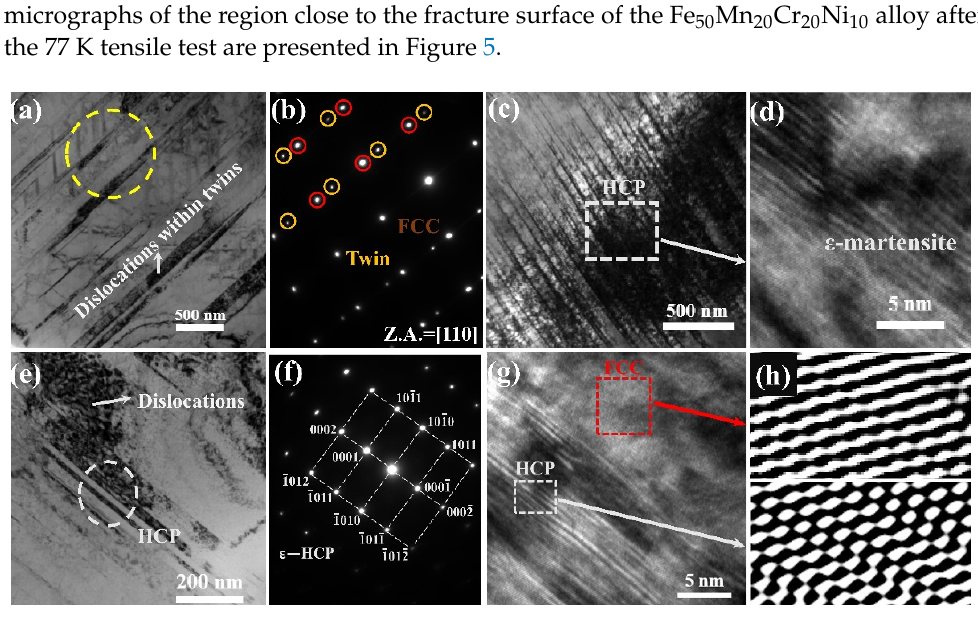
Figure 5. TEM micrographs of the region close to the fracture surface of the Fe 50 Mn 20 Cr 20 Ni 10 alloy after 77 K tensile test showing ( a ) deformation twins and dense dislocations blocked by deformation twins, ( b ) diffraction pattern taken from the selected area (in yellow circle) of ( a ). ( c ) Image of the ε -martensite and ( d ) the corresponding HRTEM image. ( e ) Bright-field images of high-density dislocations around ε -martensite. ( f ) The diffraction pattern for the selected area (in red circle) of ( e ) and ( g ) the HRTEM observation. ( h ) Corresponding inverse fast Fourier transition (IFFT) images of the rectangle region in ( g ).